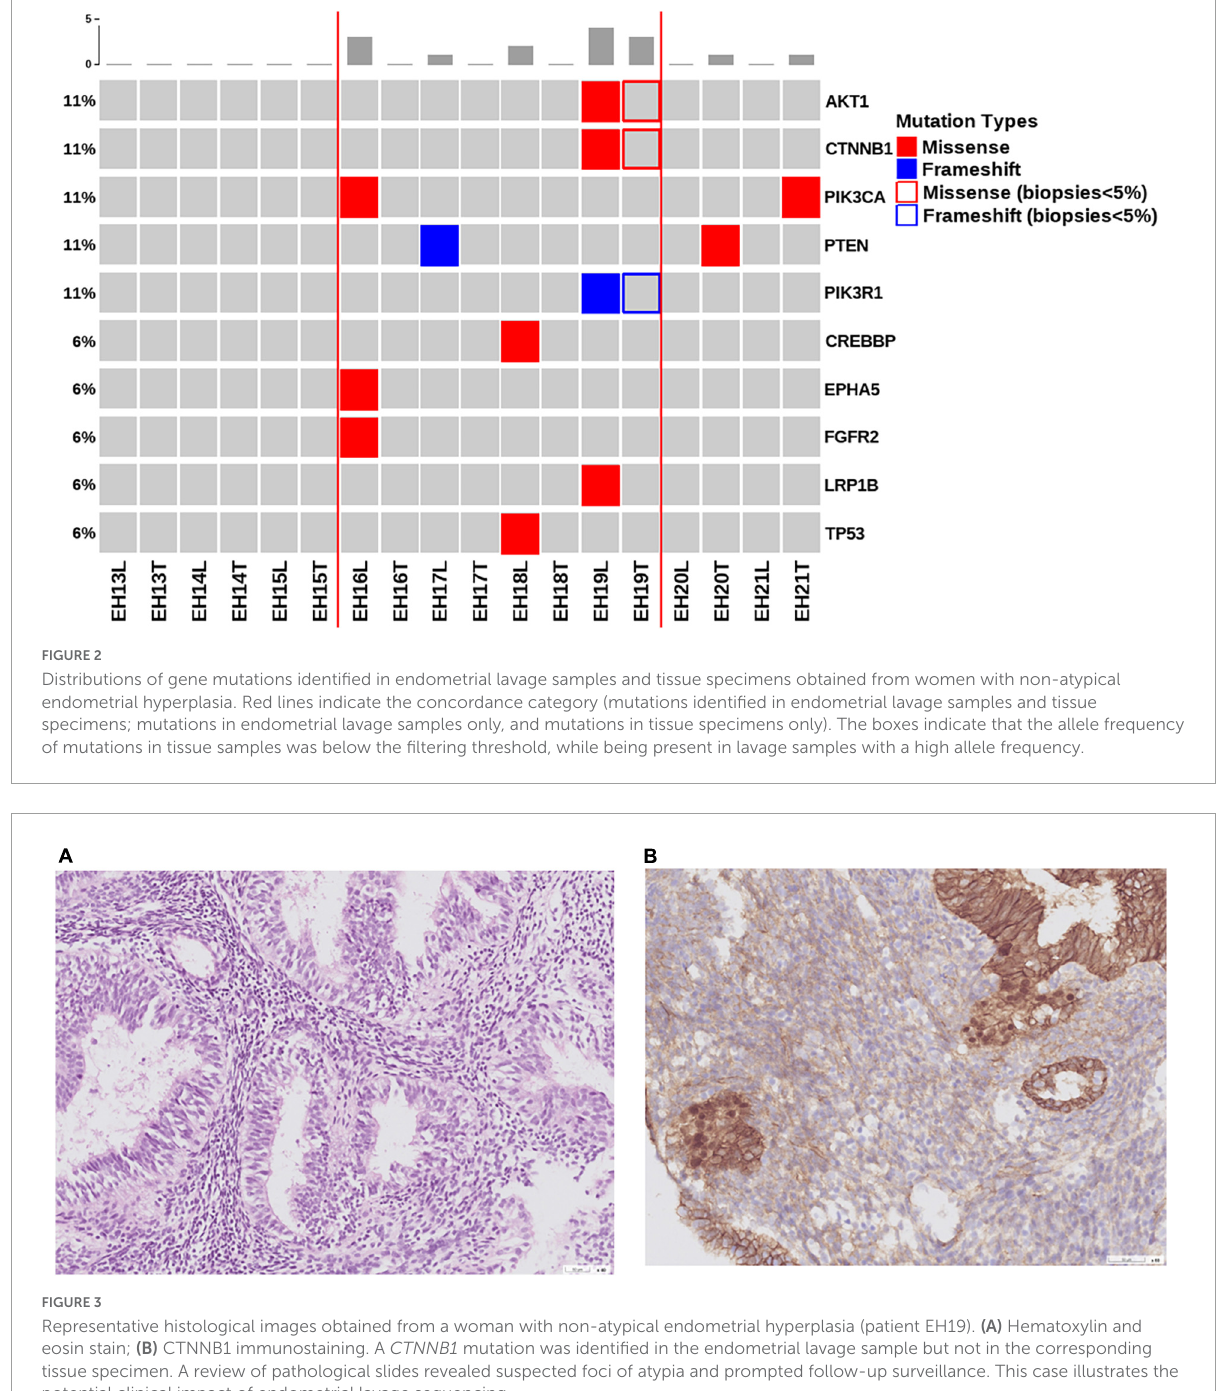
PIK3CA mutations in tissue specimens (EH20T and EH21T,